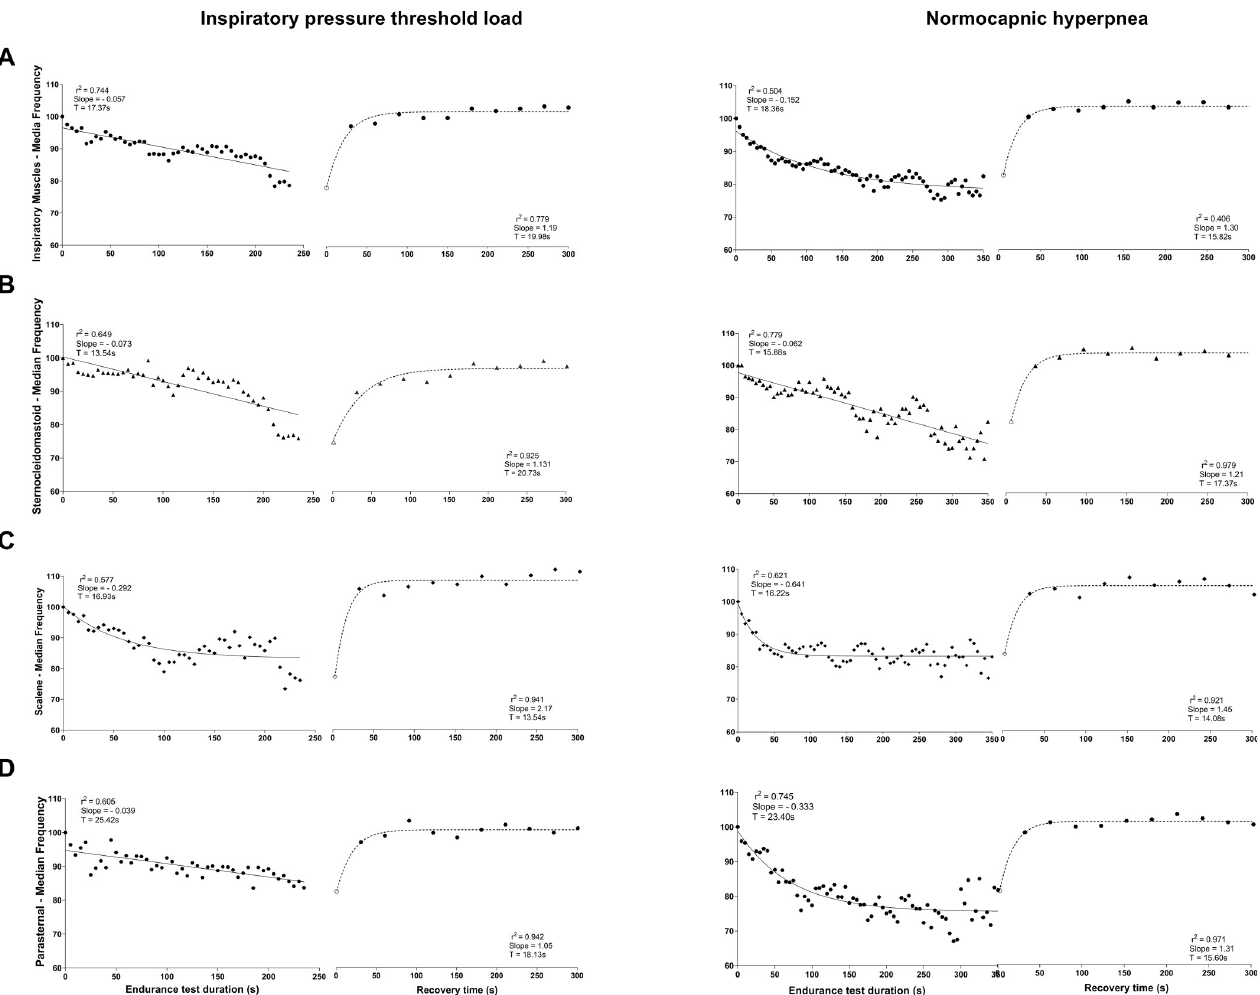
Fig 2. Time courses of normalized median frequency of inspiratory rib cage muscles. Mean of 22 subjects; inspiratory rib cage muscles (Panel A), sternocleidomastoid (Panel B), scalene (Panel C) and parasternal (Panel D) during endurance test and recovery. Each point during the test is the average of 5 seconds; during recovery, each point represents data extracted from one SNIP maneuver. In each muscle, starting point at time zero (white symbols) corresponds to the last point of endurance